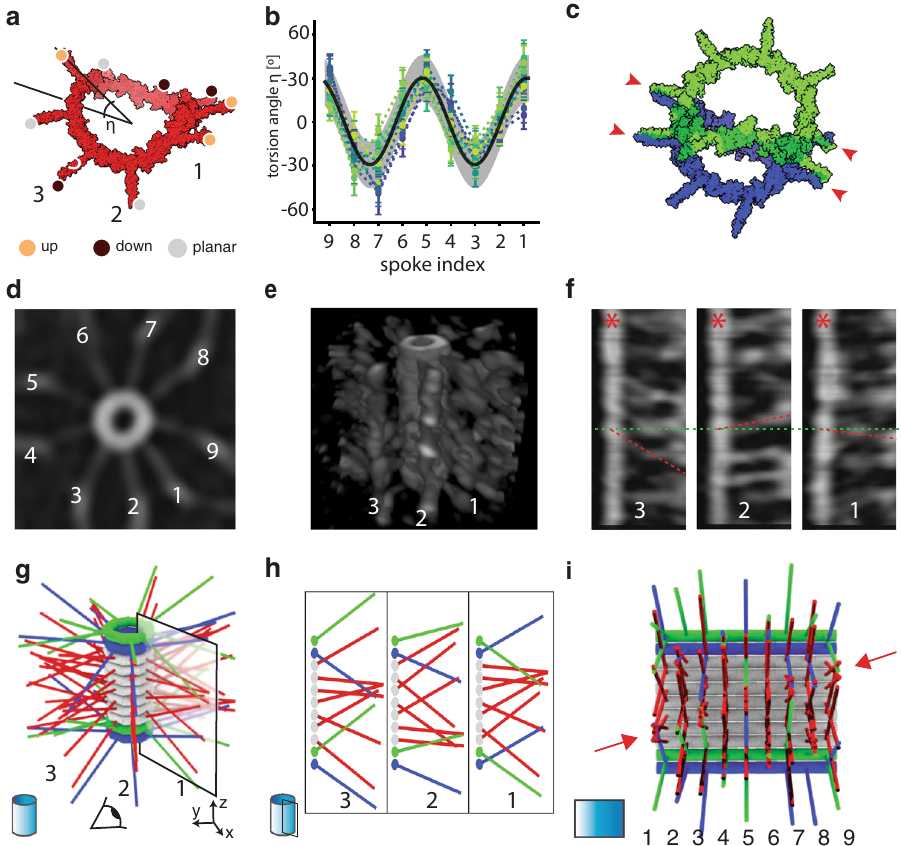
Fig. 6 Consequences of asymmetric spoke orientation on stacking mechanism. a , b Coarse-grained MD simulation of a virtual 9-fold SAS-6 ring enforced to close in solution ( a ). Torsion angle η of individual spokes along the ring circumference in MD simulations ( N = 10 independent replicates) fi tted by a cosine function ( b , black line). Error bars represent the SEM for each angle in individual simulations. c Two successive 9-fold SAS-6 rings arranged so that spoke oscillations derived from the MD simulation are in anti-phase ( c ). Unlike in the current paired model of SAS-6 ring stacking, only the spokes marked by red arrowheads are bridged between the two successive rings in this case, leaving the others available for further interactions. d – f Cryo-electron tomogram of in vitro assembled SAS-6 stack (from 39 ) without symmetrization or averaging. Individual sectors of a stack are identi fi ed in the top view maximum projection ( d ). Corresponding 3D volumetric representation of the stack with numbers indicating the three best resolved sectors in the front ( e ). Projected side views of these three sectors do not exhibit the regular arrangement expected from the paired model, as evidenced by spokes (dashed red lines) at the same height (dashed green line) not having the same orientation ( f ); the central hub is marked by red asterisks. g – i Geometrical model of multiple ring stacking, adjusting the relative in plane angle to maximize spoke contacts, leads to a regular but non-symmetrical spoke 3D arrangement ( g ). The regular repetition of angles along the ring circumference leads to a position-dependent distribution of spoke angles η in each sector, best visible in the side view ( h ). Lateral visualization unwrapped to obtain a complete view of the cartwheel surface, showing a chiral arrangement of spokes (diagonal spoke merging indicated by red arrows) (